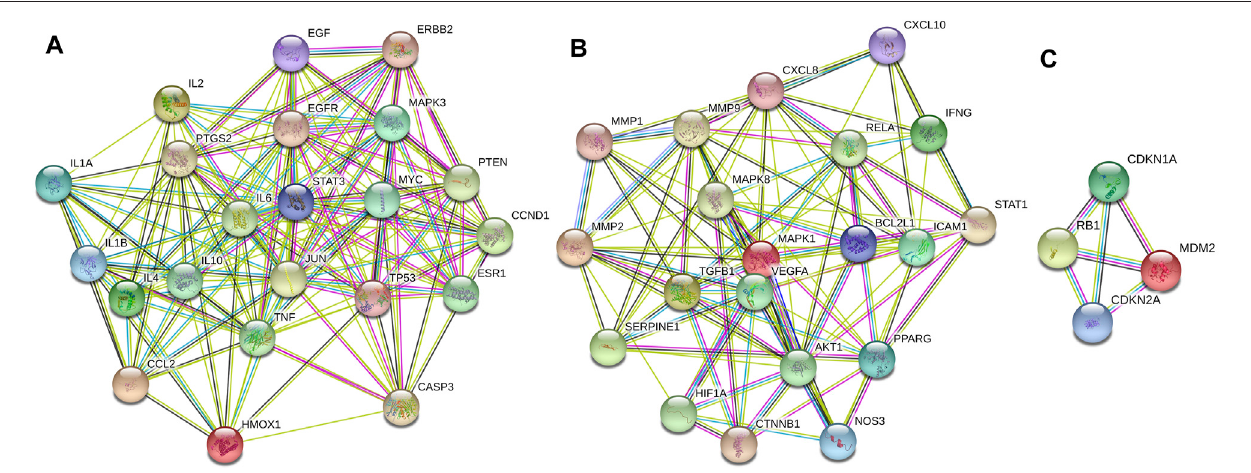
FIGURE3| Clusterofthe80overlappinggenes-containingPPInetwork.Threeclusterswereidenti fi ed. (A – C) standforClusters1,2,and3,respectively.Cluster1 had highest score of 15.238, and TP53 was identi fi ed as the seed gene. Cluster 2 had the score of 10.526, and MAPK8 was the seed gene. Cluster 3 had the score of 4.0, and MDM2 was the seed